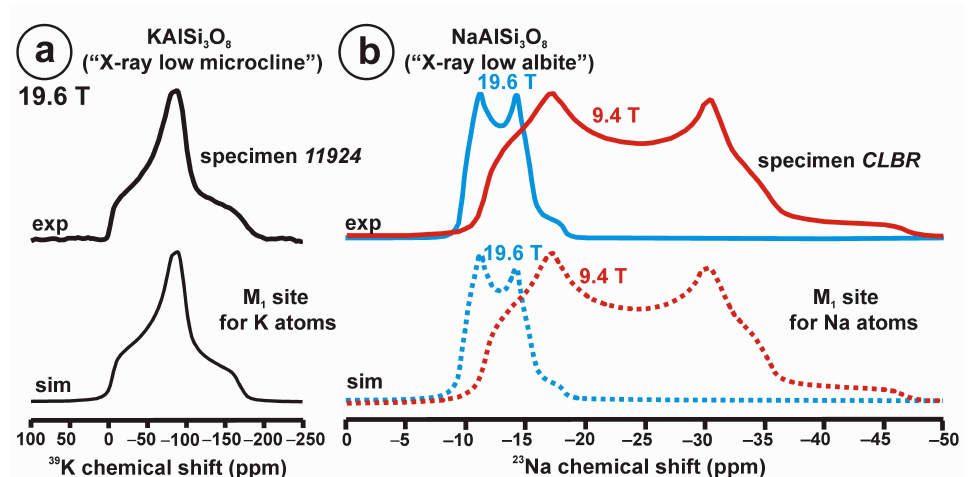
Figure 26. ( a ) The 39 K MAS NMR spectrum of specimen 11924 at 19.6 T. The K atoms occupy a single M 1 site, as inferred from the C 1 lattice model of the “X-ray low microcline” variant of KAlSi 3 O 8 . ( b ) The 23 Na MAS NMR spectrum of specimen CLBR at 9.4 T (red) and 19.6 T (blue) for Na atoms at a single M 1 site, as inferred from the C 1 lattice model of the “X-ray low albite” variant of NaAlSi 3 O 8 . See reference [4] for the experimental procedure for the spectra at 9.4 T and 19.6 T; ν r = 10